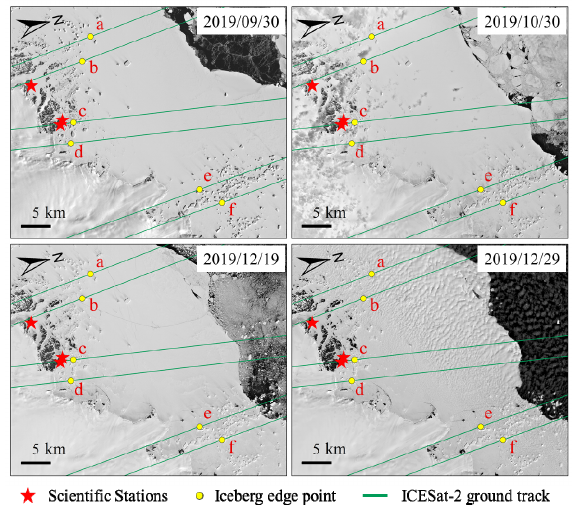
Figure 6 . The time series of Sentinel-2 satellite optical images. The iceberg edge points and ICESat-2 ground tracks used for the retrieval experiment are marked above, and the information of the three scientific stations is shown in Figure